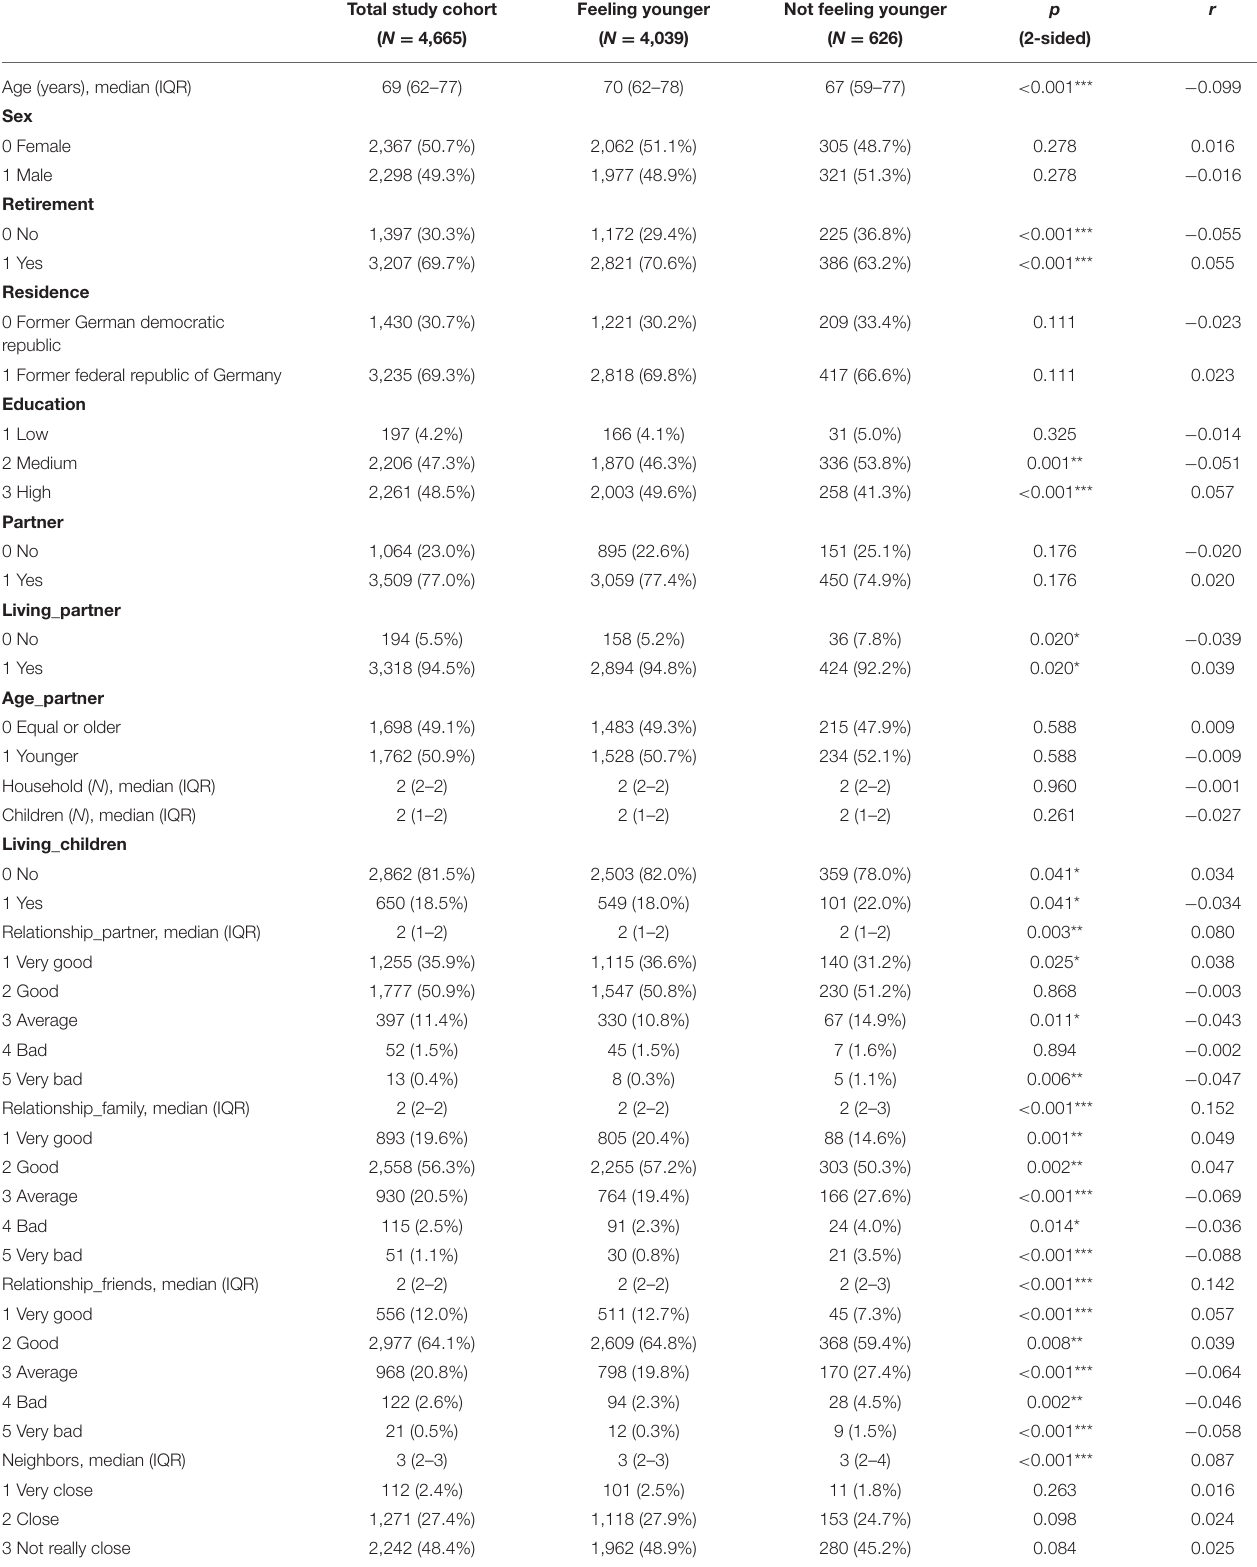
TABLE 1 | Summary of variables stratified by feeling younger